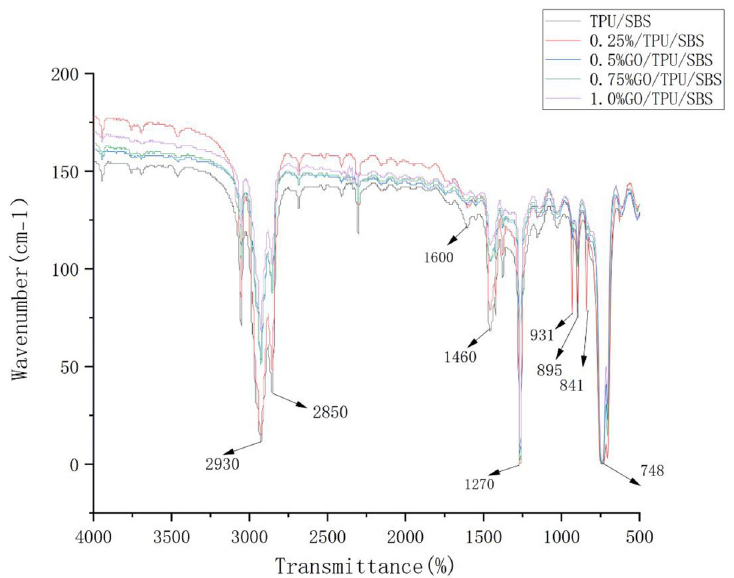
Fig 10. The FTIR test results of modified asphalt with different GO